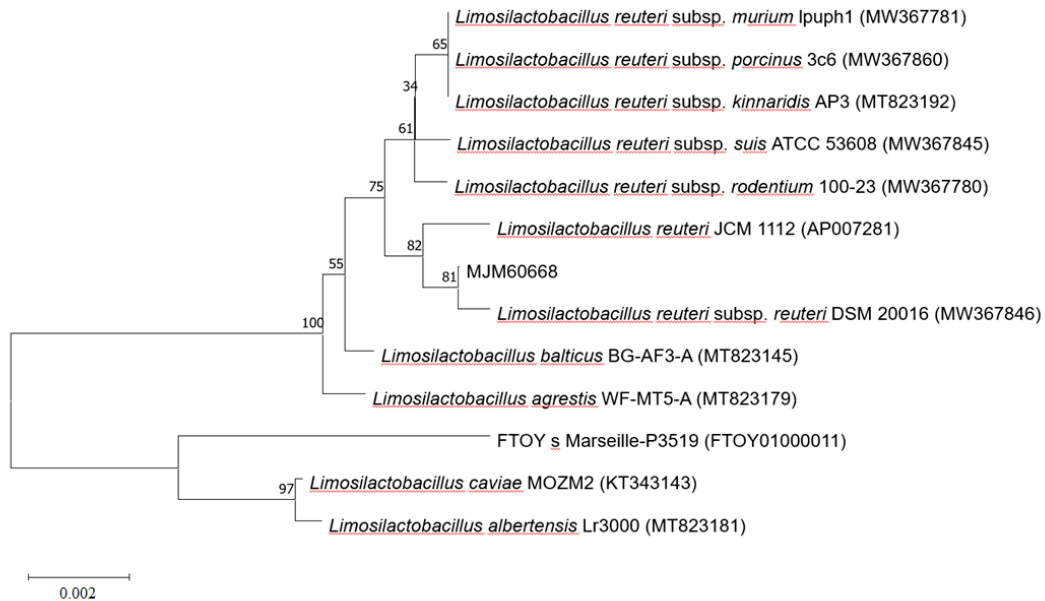
Figure 1. Phylogenic analysis of MJM60668. Phylogenetic analysis was performed by the neighbor-joining method, using MEGA11 software. Numbers on the branches represent the bootstrap values (%) from 1000 replicates. The evolutionary distances were computed using the Kimura 2-parameter method. The scale bar indicates substitutions of 0.002 per nucleotide position.